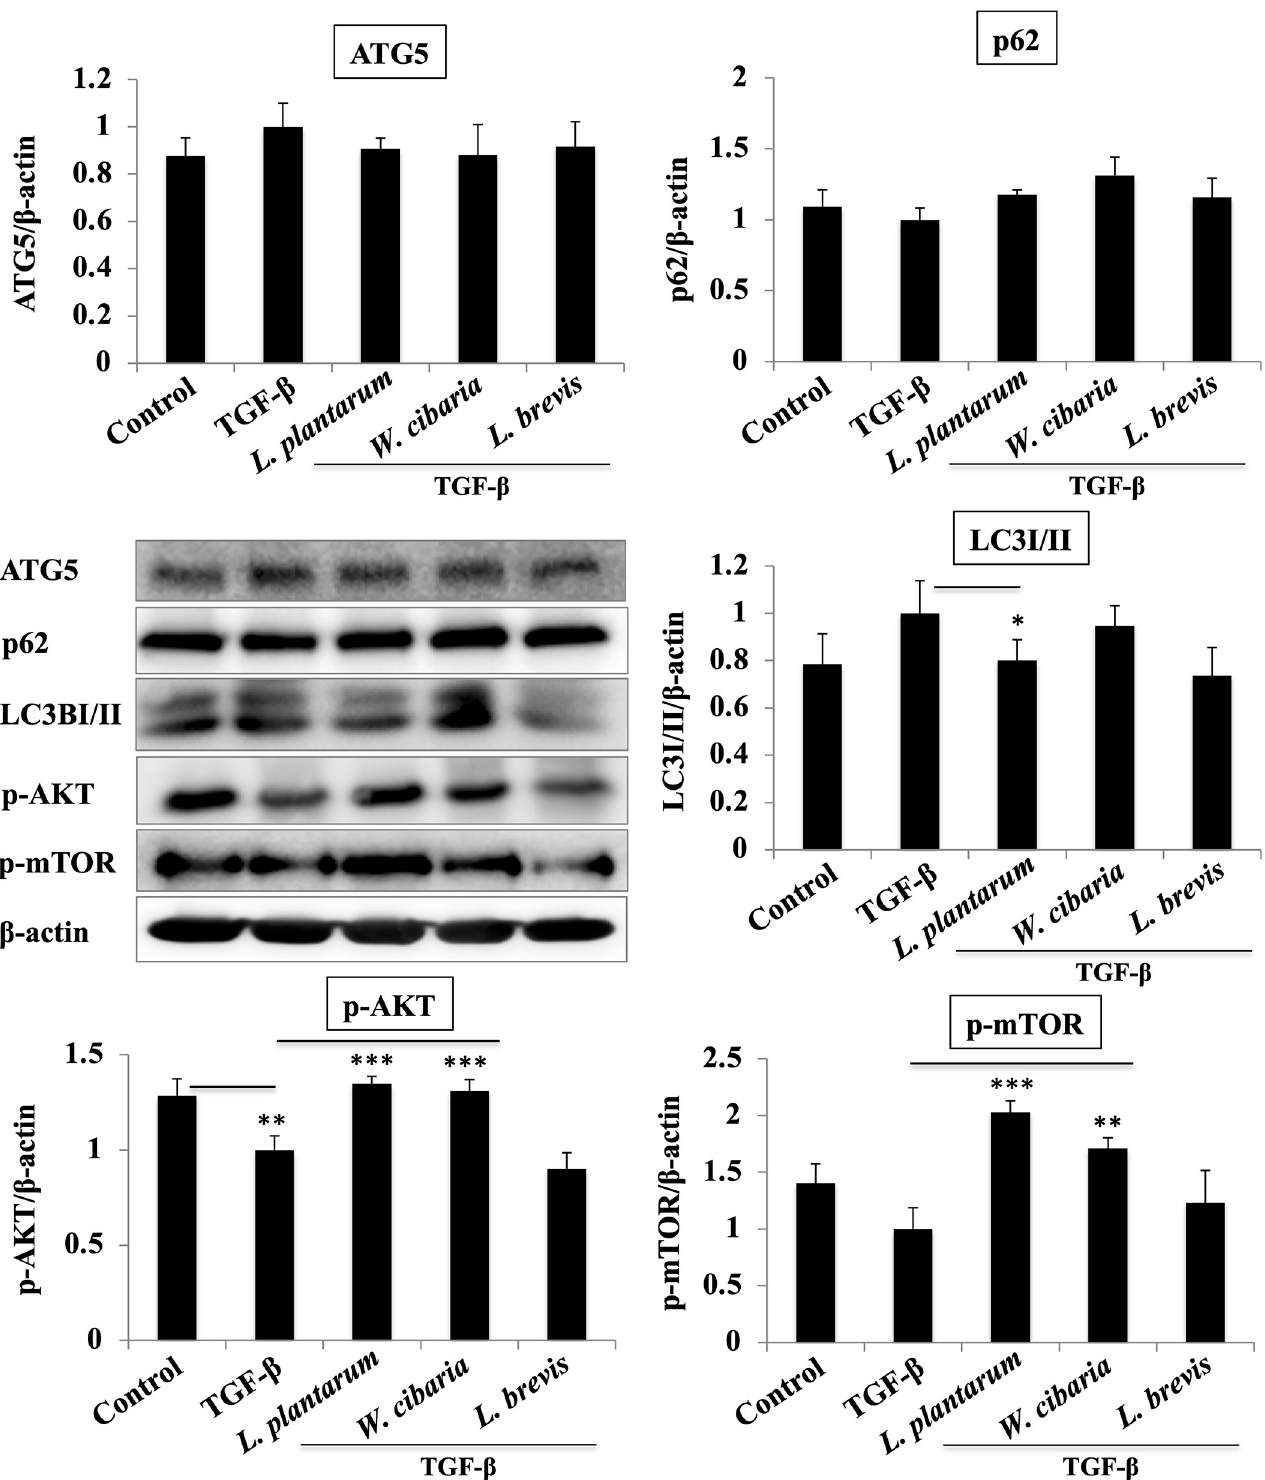
Fig 7. LAB strains modulate the autophagy-associated markers in LX-2, in response to TGF- β . Confluence LX-2 cells were treated with LABs for 48 h, and stimulated with TGF- β for 120 minutes. Western blot was performed to determine the level of ATG5, p62, LC3I/II, and p-AKT and p-mTOR at the indicated time point. Image J software was used to determine the intensities of the protein bands. The bar graphs are the average of two different experiments (mean +_S. D). � p < 0.05, �� p < 0.01, ��� p < 0.001.